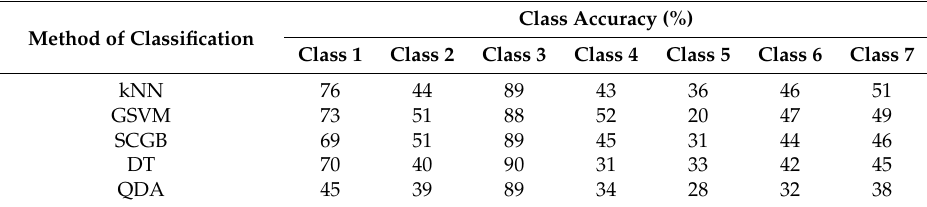
Table 6. Individual class accuracies of NDVI-based land cover